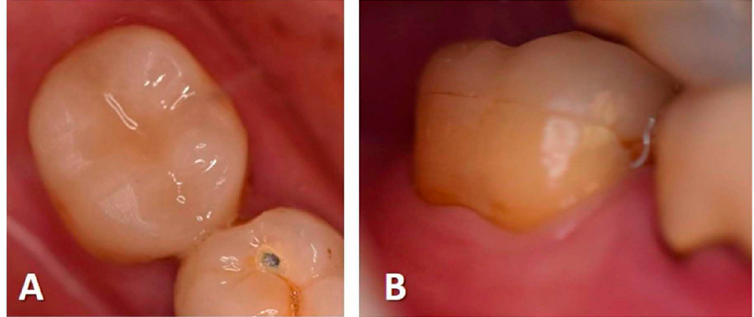
Figure 2. Cerec ® screenshots for endocrown modeling (( A ): occlusal view of the preparation; ( B ): distal Figure3. Intraoralphotographsoftooth47at18monthspostoperative(( A ):occlusalview; ( B Figure 3. Intraoral photographs of tooth 47 at 18 months postoperative (( A ): occlusal view; ( B ): buccal view).